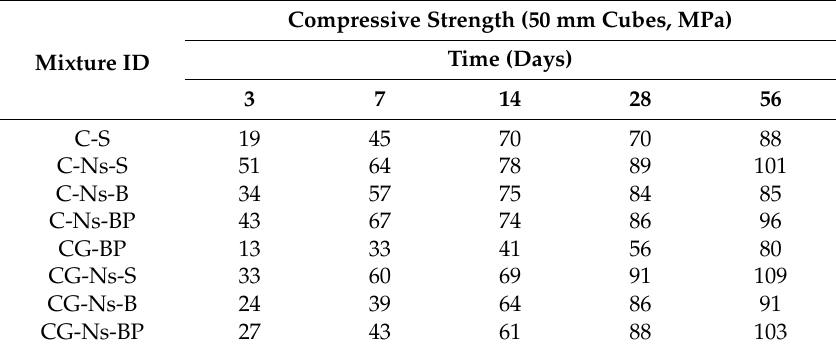
Table 4. Results of compressive strength at different